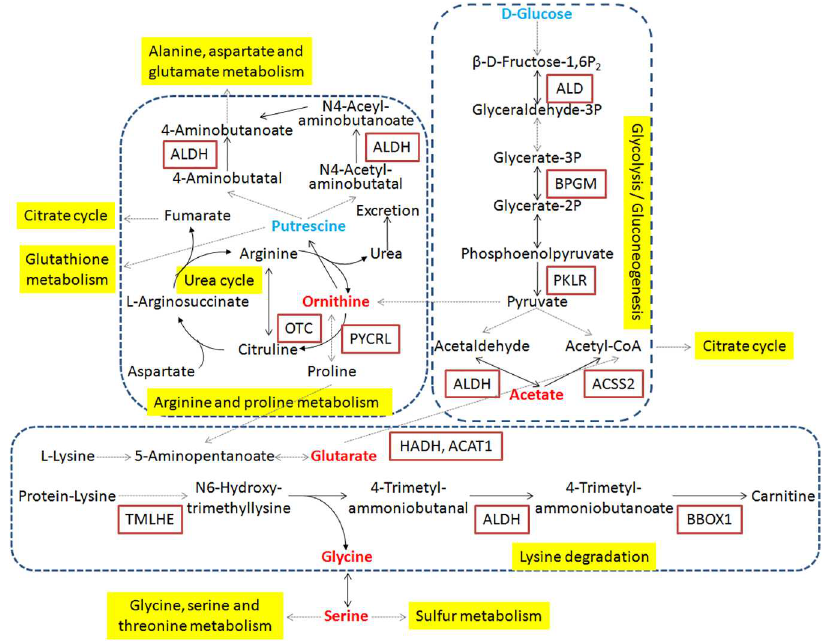
Fig 4. The networks of significantly altered metabolic pathways in response to gypenoside. Pathways are showedin yellow dashedareas. Proteins are showedin rectangles, and metabolites are showedin no rectangles. Red representsup-regulation in gypenoside group comparedto model group, and blue represents down-regulation.